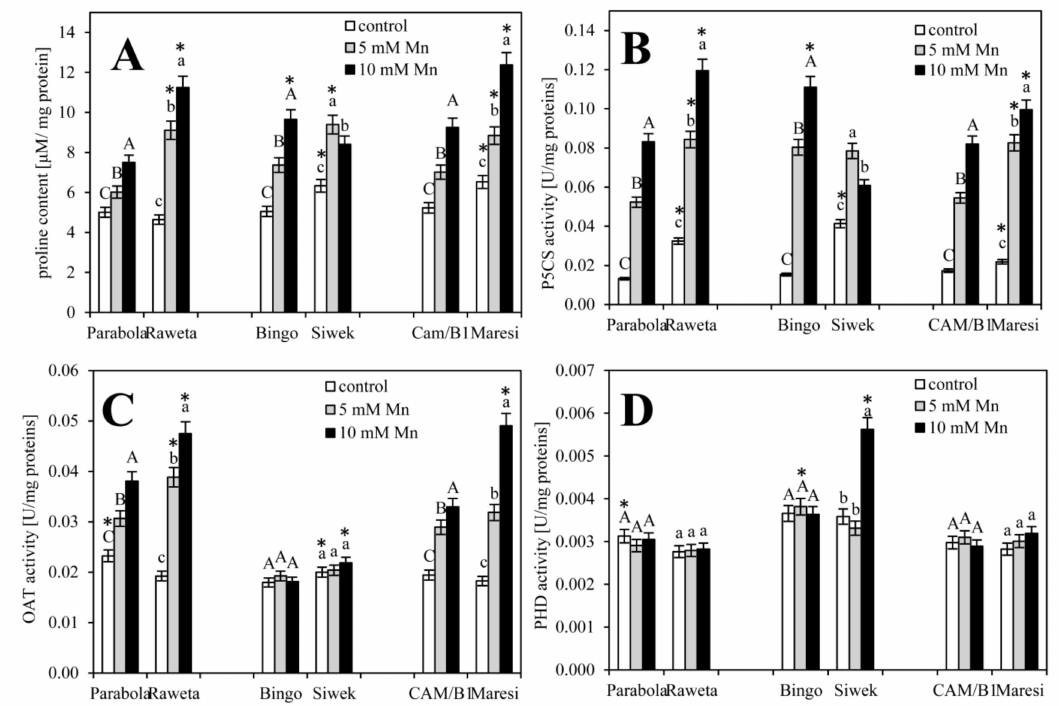
Figure 4. ( A )-Proline content [ µ M · mg − 1 protein]; ( B )-P5CS; ( C )-OAT and ( D )-PHD [U / mg protein] activity in the first leaves of wheat (Parabola-tolerant and Raweta-sensitive), oats (Bingo-tolerant and Siwek–sensitive) and barley (CAM / B1-tolerant and Maresi-sensitive) cultivars, grown in control and at 5 and 10 mM MnCl 2 . Values are mean of five replications ( ± SE). Di ff erent letters indicate significant ( p < 0.05) di ff erences between treatments. Di ff erences between cultivars are marked as